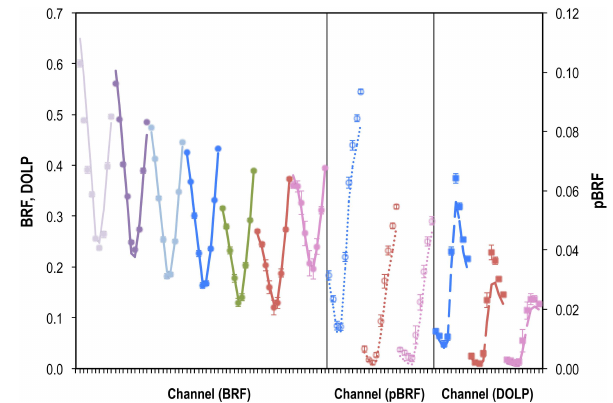
Fig. 15. Same as Fig. 14 except for the Fresno residential area tar- get. Due to the slightly different position of this target within the instrument field of view, view zenith angles from left to right are 67.9, 61.6, 51.1, 33.2, 5.3, 27.0, 45.8, 57.5, and 64.8 ◦ within each of the spectral